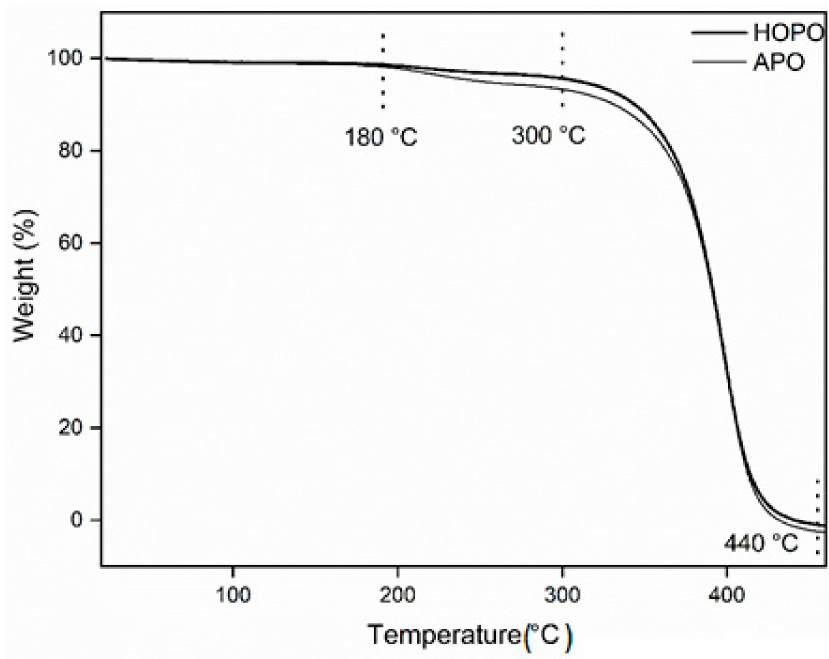
Figure 3. TGA curves of palm oil APO and